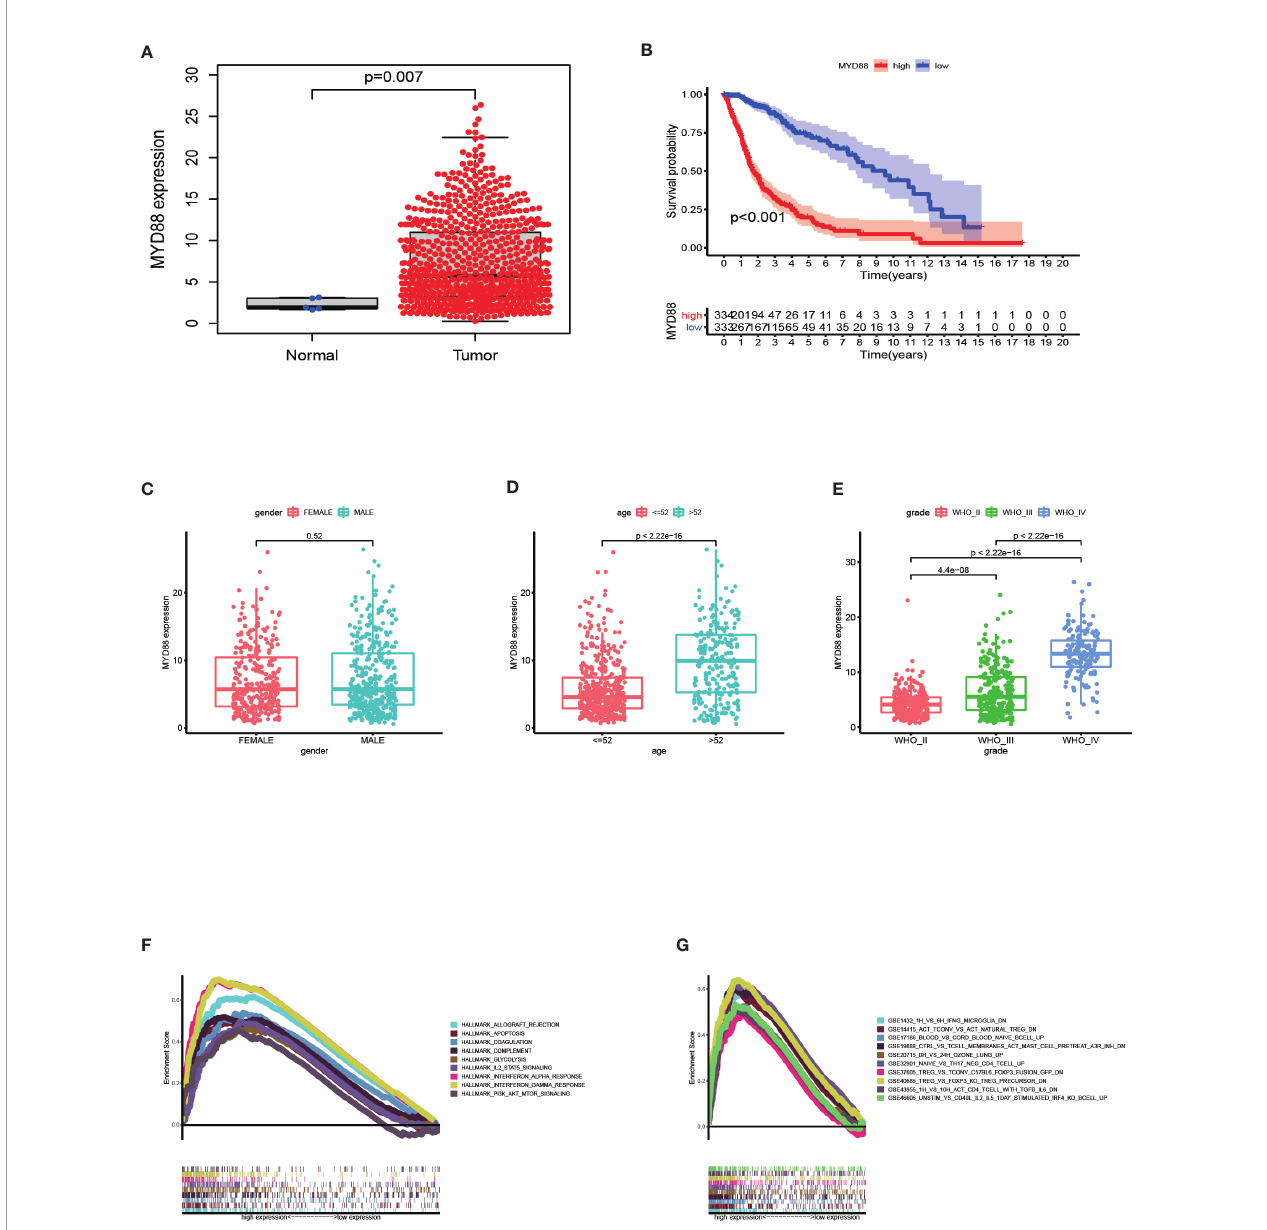
FIGURE 4 | MYD88 was associated with the overall survival, age, WHO grade and enriched in immune pathways. (A) The MYD88 expression were signi fi cantly lower in normal tissues as compared to the glioma tissues. (B) MYD88 lower expression was associated with signi fi cantly longer overall survival. (C) The MYD88 expression was similar between male and female patients. (D) MYD88 expression was higher in patients with age > 52 years. (E) MYD88 expression was higher in patients with higher WHO grade. (F) The genes in MYD88 high-expression group were mainly enriched in immune related pathways. (G) For C7 collection de fi ned by MSigDB, the immunologic gene sets, multiple immune functional gene sets were enriched in the high MYD88 expression